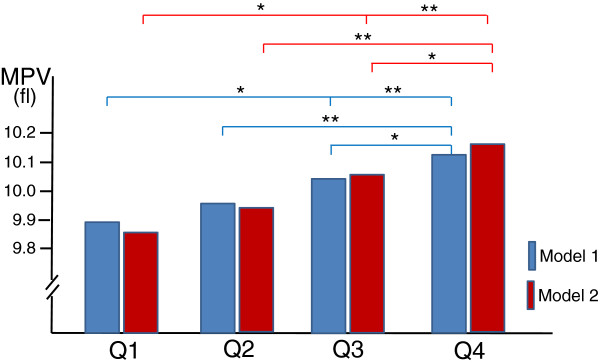
MPV in different fasting plasma glucose groups in noncdiabetic subjects. One asterisk means P < 0.05, two asterisks mean P < 0.01. Model 1; adjusted for age and sex. Model 2; adjusted for age, sex, systolic blood pressure, diastolic blood pressure, BMI, uremic acid, total cholesterol, triglyceride, HDL-cholesterol, LDL-cholesterol, smoking, and alcohol ingestion.